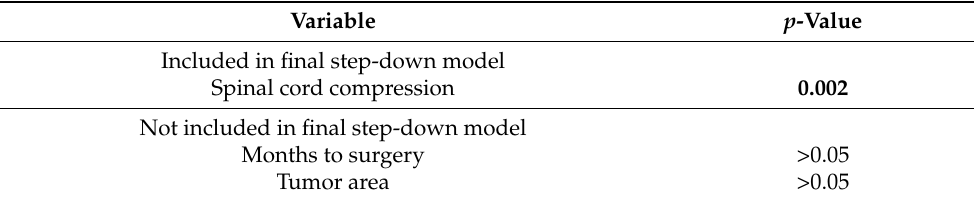
Table 7. Final step-down multivariable logistic regression model predicting improvement in